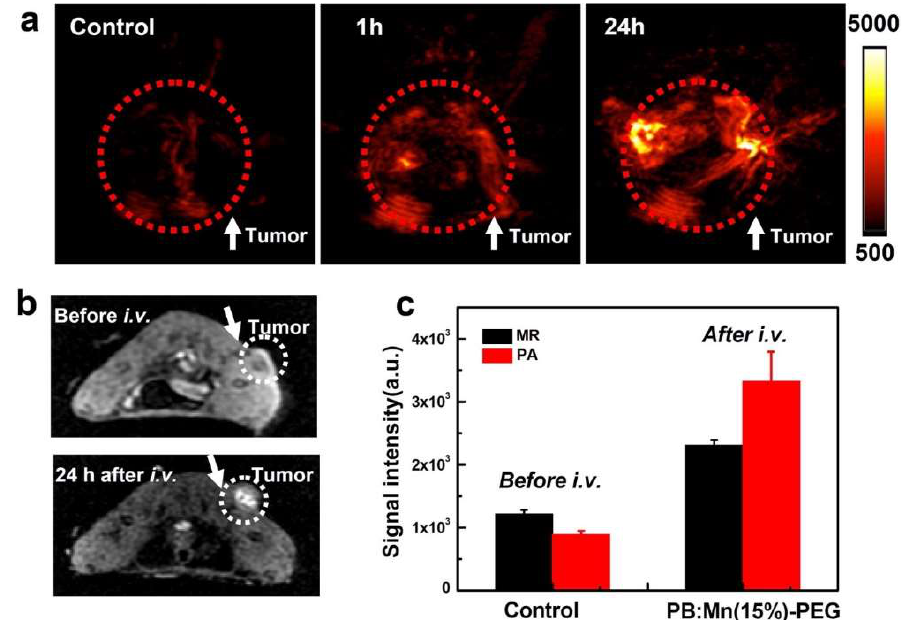
Figure 6. In vivo photoacoustic and MR imaging with Mn 2+ doped PBnp. ( a ) 2D photoacoustic imaging of tumors before and after injection of Mn 2+ doped PBnp. ( b ) In vivo T1-weighted MR images of a mouse taken before injection ( upper ) and 24 h post injection ( bottom ) of Mn 2+ doped PBnp. Brightening effect showed up in the tumor after i.v. injection of Mn 2+ doped PBnp. ( c ) T1-weighted MR signal intensities and PA signal intensities in the tumor before injection and 24 h post injection of Mn 2+ doped PBnp. Reprinted with permission from Ref. [60]. Copyright 2015 American Chemical Society.